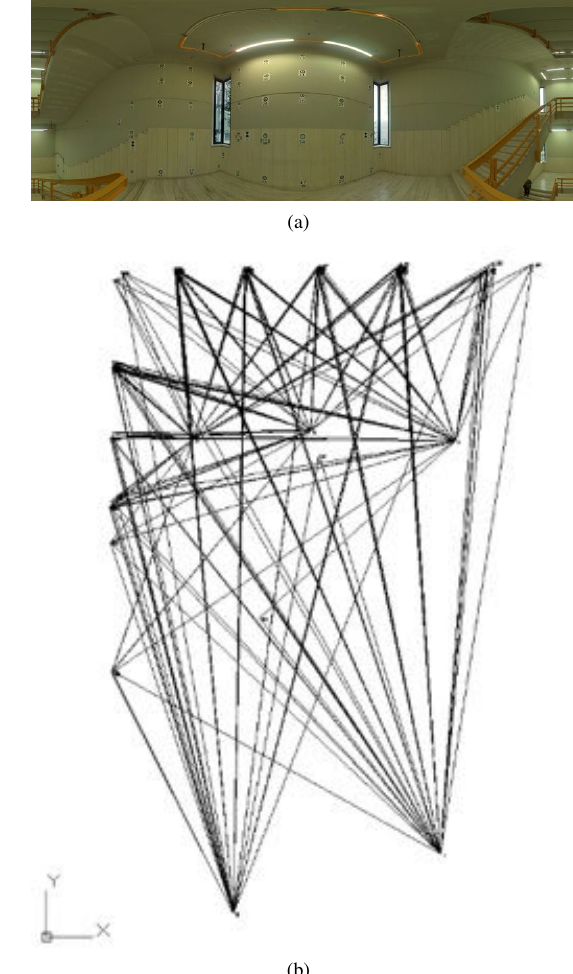
Figure 3. Testing environment used for the evaluation of met- ric accuracy. (a): One of the 5 stations, where are visible the markers of known coordinates. (b): Orientation network of the photogrammetric model.